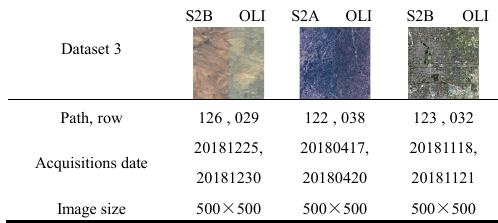
Table 4. Sentinel-2 MSI and Landsat-8 OLI study areas